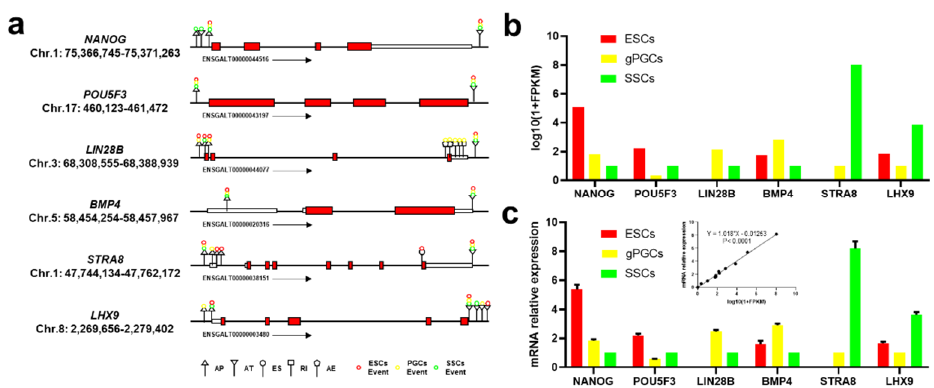
Figure 5. Validation of AS events and crucial gene expression. ( a ) The gene transcript structure and AS events of crucial genes in male chicken germ cell differentiation. The red square is exon, the different color cycles are AS events, and the purple arrow represents the qRT-PCR primers at the constitutive exon loci. ( b ) The gene expression of RNA-seq data. ( c ) The gene expression of qRT-PCR results and correlation analysis.